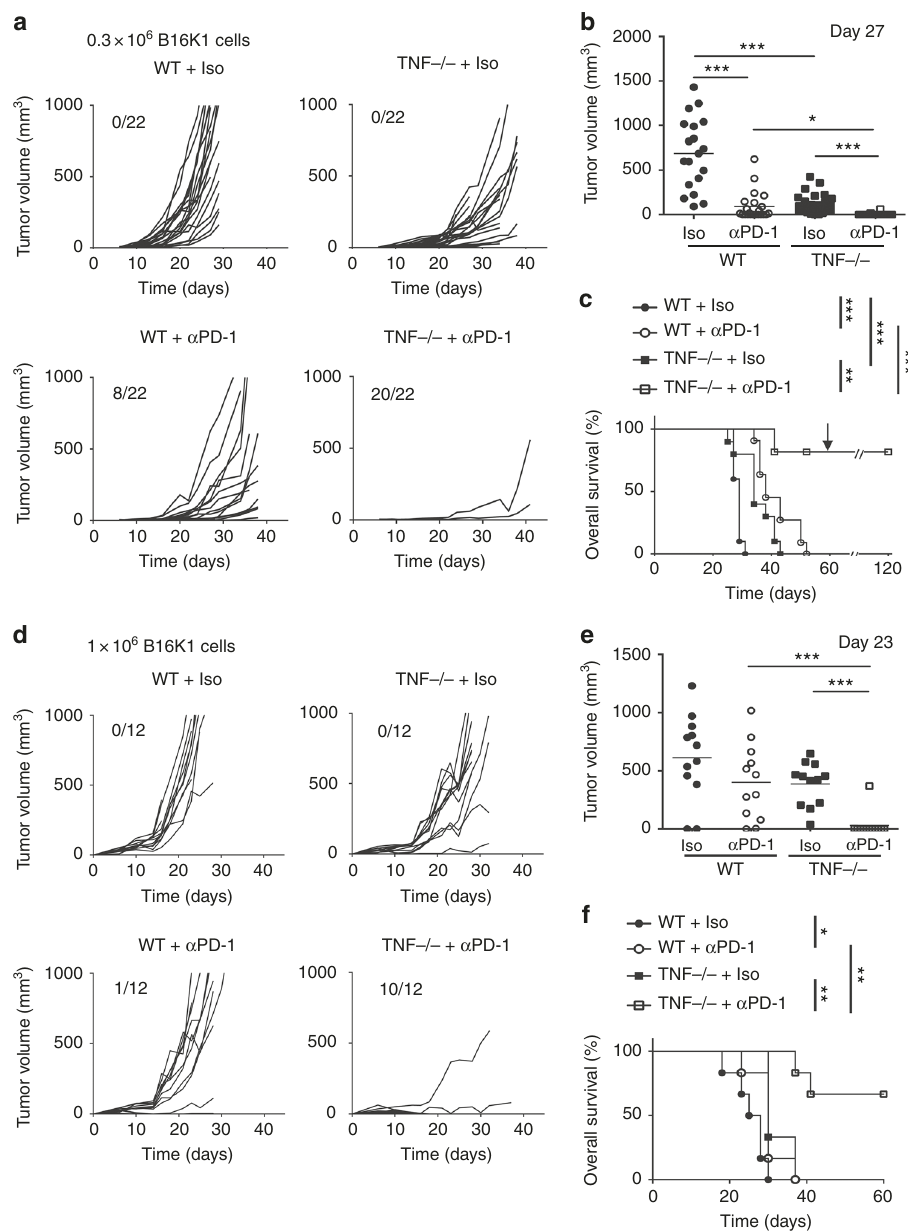
Fig. 1 TNF de fi ciency enhances anti-PD-1 response in a mouse melanoma model. C57BL/6 wild-type (WT) and TNF-de fi cient (TNF − / − ) mice were intradermally and bilaterally grafted with 3 × 10 5 ( a – c ) ( n = 11 mice per group) or 1 × 10 6 ( d – f ) ( n = 6 mice per group). B16K1 melanoma cells prior to intraperitoneal injection of anti-PD-1 antibodies ( α PD-1, 10 mg kg − 1 ) or a relevant isotype control (Iso, 10 mg kg − 1 ) at days 6, 10 and 13. a and d Tumor volumes were determined with a calliper. Individual curves are depicted for each tumor. Numbers indicate complete tumor regression out of total tumors. Data are from three independent experiments. b and e Tumor volumes determined at the indicated days for individual tumors are depicted. Bars represent mean values ± s.e.m. (Mann – Whitney U test: * p < 0.05; ** p < 0.01; *** p < 0.001). c and f Cumulative survival curves (Logrank test: * p < 0.05; ** p < 0.01; *** p < 0.001). At day 60, surviving mice were challenged with a second B16K1 injection as indicated by the arrow; mice did not develop tumors and